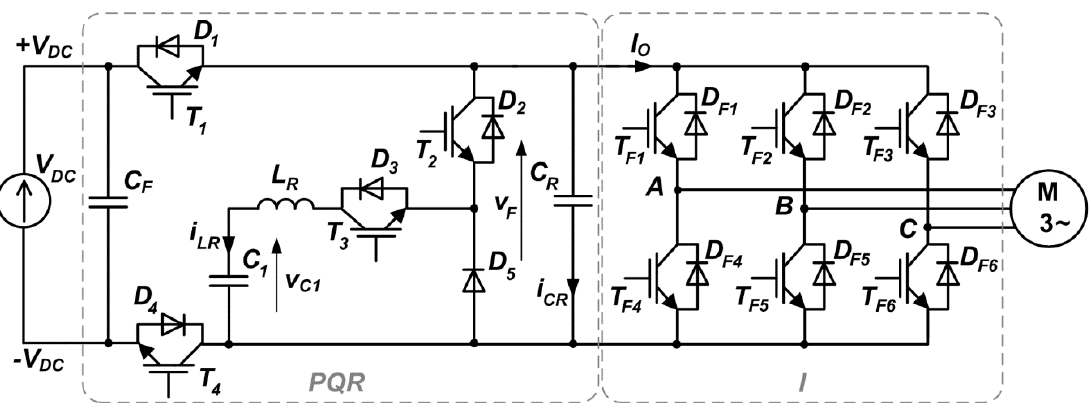
Figure 1. Parallel quasi-resonant DC link inverter: PQR—parallel quasi-resonant circuit, I—inverter, M—induction motor.